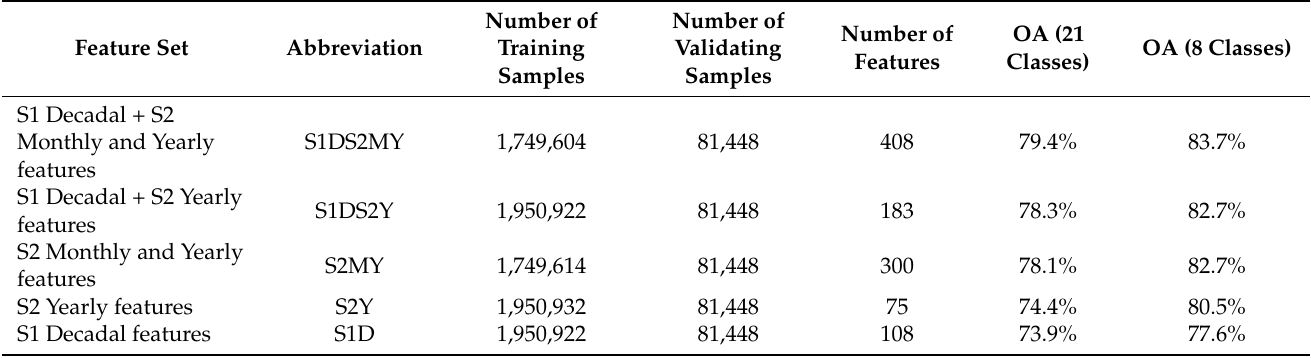
Table 6. Five different input data scenarios generated from S1 and S2 features. Shown are the number of training and validating samples as well as the number of features. Moreover, the overall accuracy (OA) of applying an RF classifier on different feature sets (using all 21 and 8 aggregated LULC classes) and evaluating with validation data are